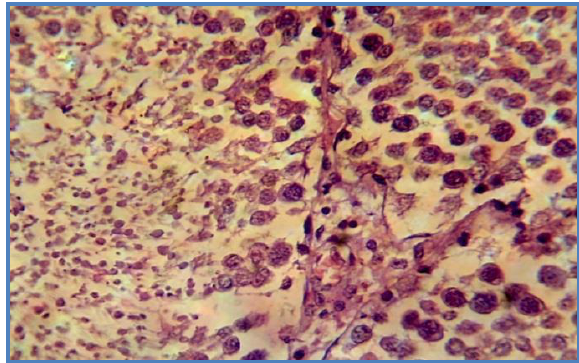
Figure, 1: Cross section of the rat testes group T1 showing decrease in thickness of basement of seminiferous tubules with in complete spermatogenesis (H and E stain 40 x).